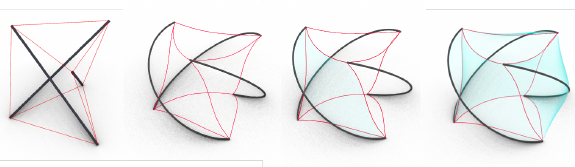
Figure 2: From left to right, successive conceptual transformations of a T3 tensegrity module resulting in a structure with floating arches, cables, and